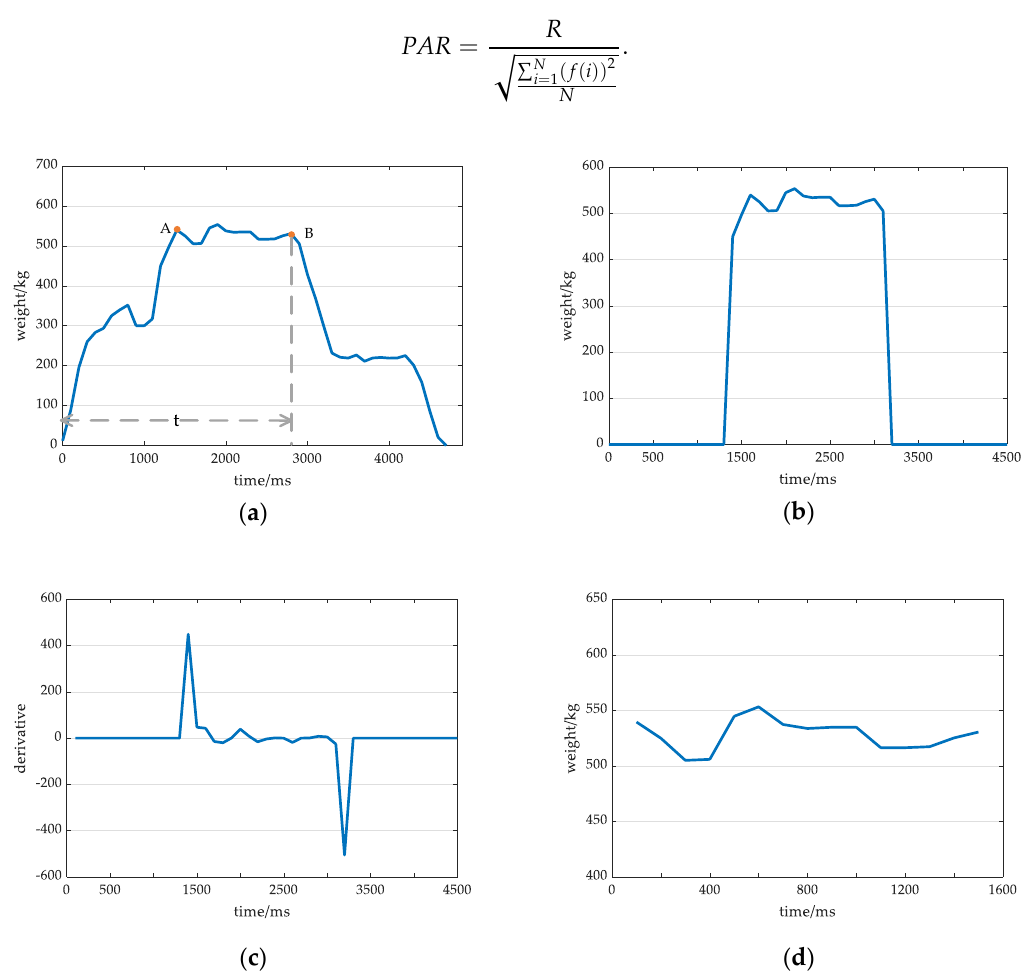
Figure 3. Effective signal acquisition process: ( a ) Original signal from cow weighing; ( b ) The signal processed based on the threshold K1; ( c ) The derivative of the signal in ( b ); and ( d ) Valid data.